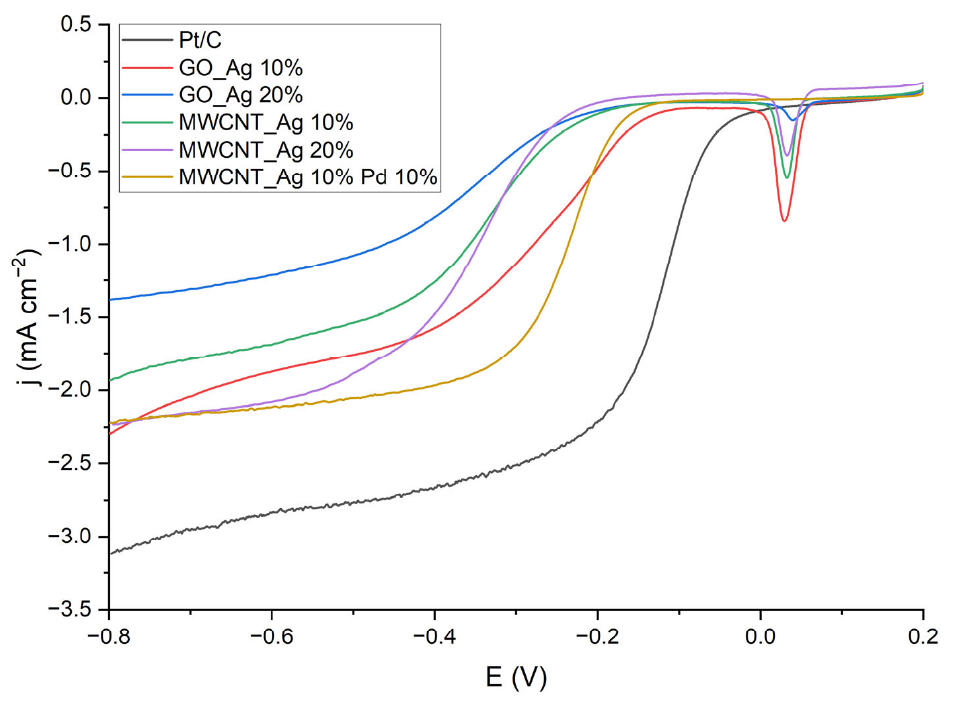
Figure 6. Linear voltammograms of the oxygen reduction reaction in a 0.1 M KOH solution saturated with oxygen on the test catalysts at an electrode rotation speed of 1000 rpm.